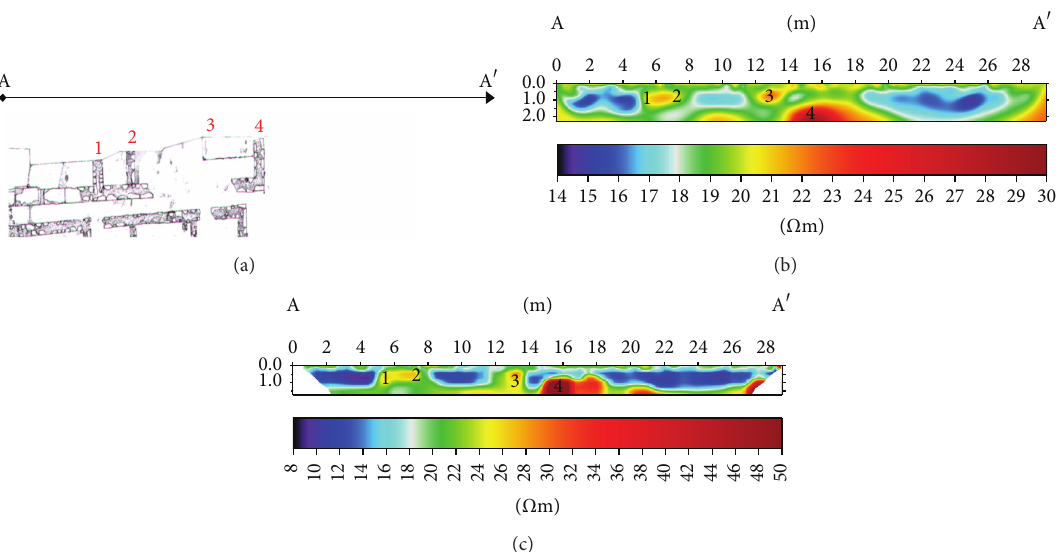
Figure 9: Results of a dipole-dipole survey carried out on the plane of Himera to detect buried archeological structures. (a) Map of the archaeological excavation (the black arrow indicates the position of the survey). (b) Filtered Jacobian damped LSQR imaging. (c) Standard least-squares constrain inversion. The black numbers indicate some resistive localized anomalies, which are well related to wall-like relics (red numbers).